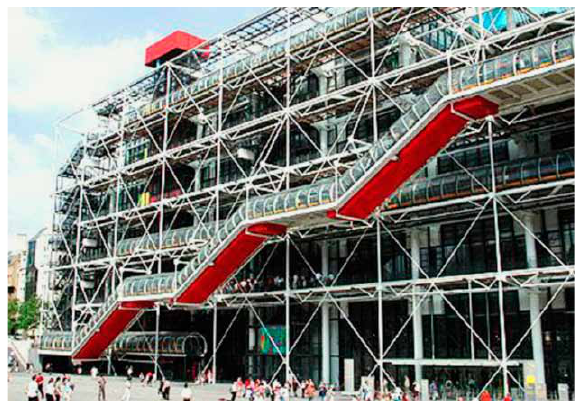
fig. 2. Pompidou Center (photo by the authors)